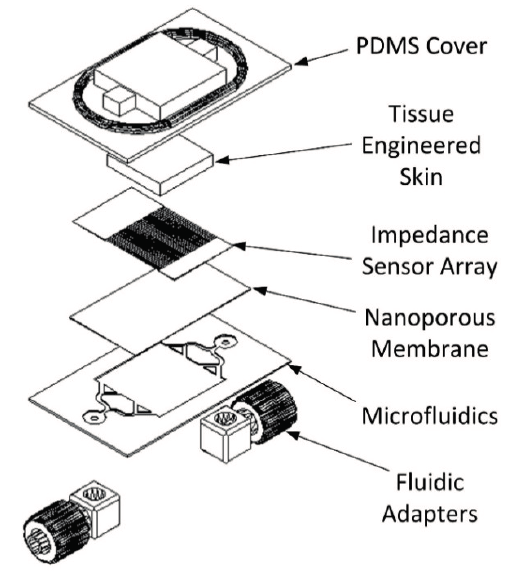
Figure 1. Exploded schematic of the bio-hybrid tactile sensor